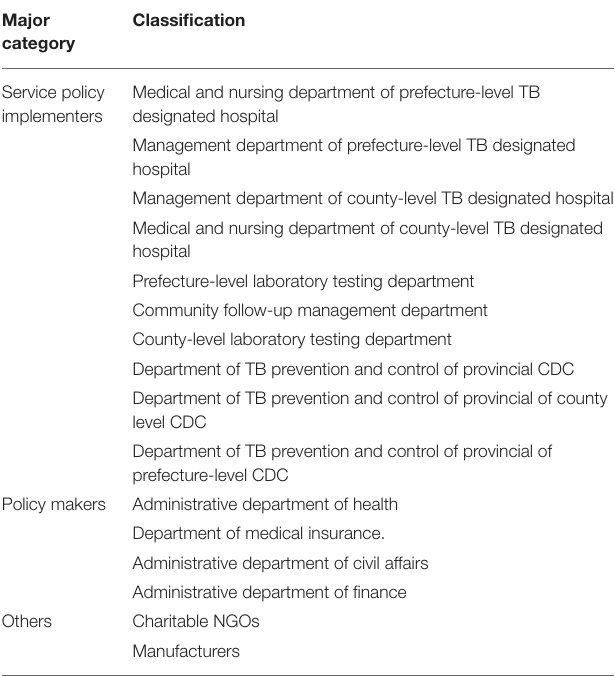
TABLE 1 | Classification of stakeholders among service providers of RR-TB.